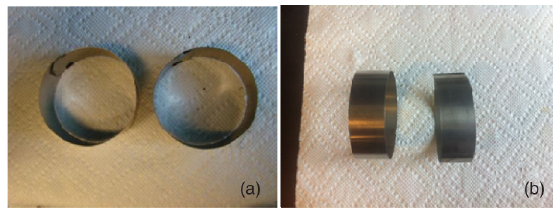
FIG. 5. Etching samples: (a) top view (b) side view.